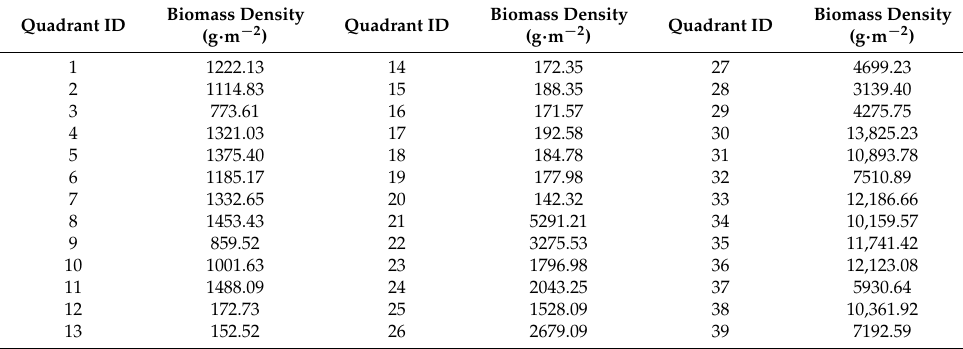
Table 3. Information for the biomass density of each quadrant. Quadrants 1–11 were selected in the terrestrial phase; quadrants 12–20 were selected in the water phase; quadrants 21–39 were selected in the reservoir phase.